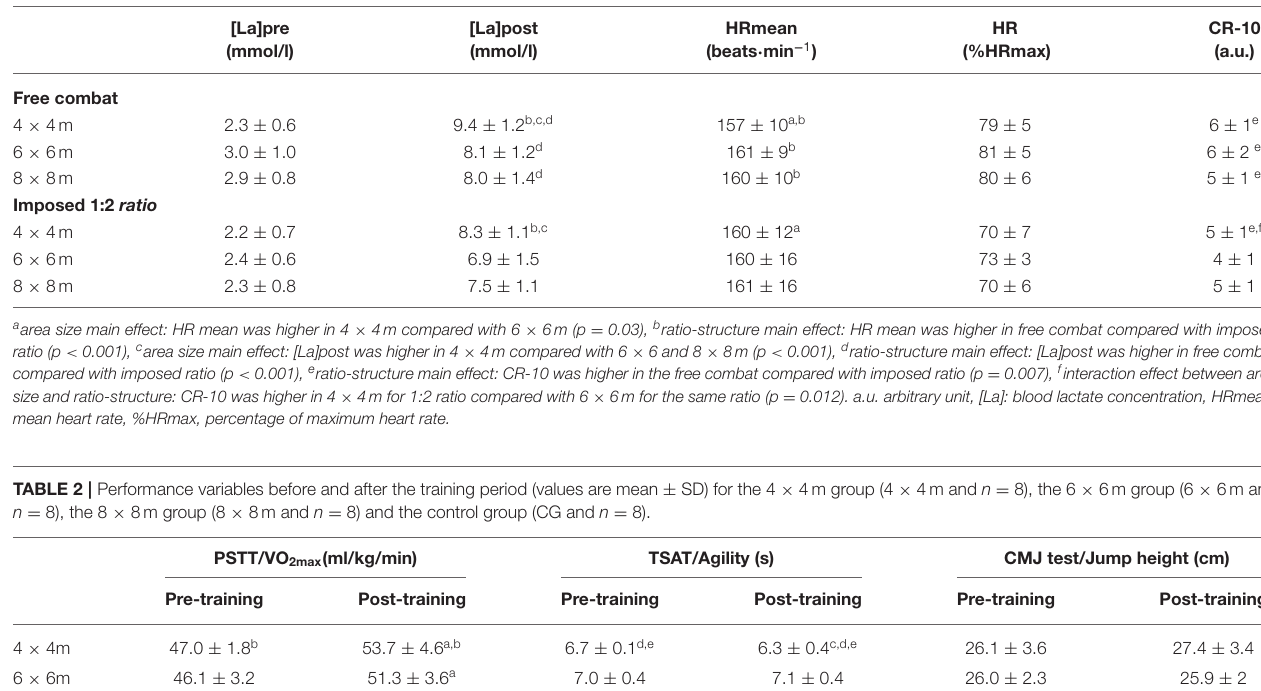
TABLE 1 | Physiological responses and rating of perceived exertion values recorded during different experimental conditions (values are mean ± SD, n = 32).